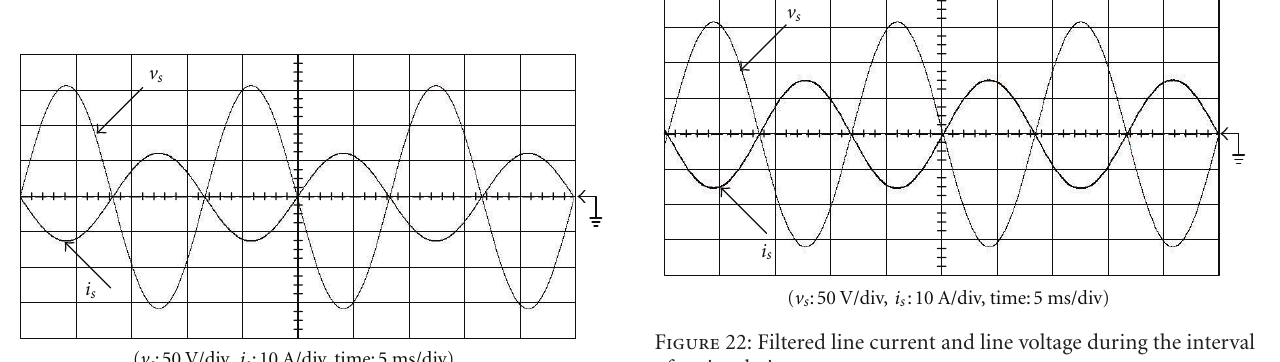
Figure 22: Filtered line current and line voltage during the interval of no insolation.